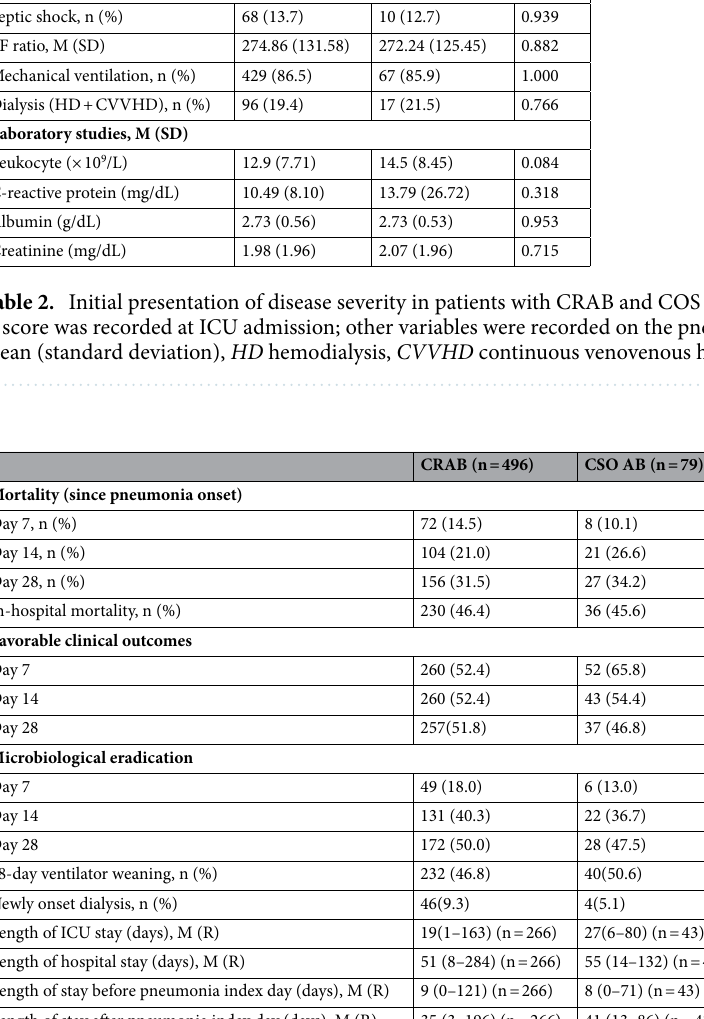
Table 3. Treatment outcomes of patients with CRAB and COS -AB pneumonia. The analysis of the length of hospital and ICUICU and hospital stays, and length of stay before and after pneumonia index day did not include patients who expired during hospitalization. M (R) median (range). Significant values are given in bold. a Mann-Whitney U test.